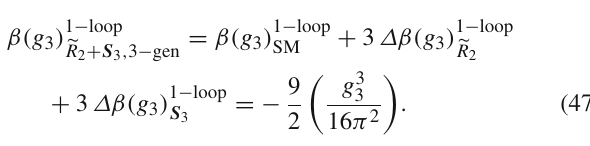
Fig. 2 Running of gauge coupling g 3 with the energy scale μ for dif- ferent leptoquark models at one-loop and two-loop order. The green curve represents SM; the red and yellow ones signify the extension of SM with one and three generations of (cid:2) R 2 , respectively; the addition of one and three generations of S 3 to SM is indicated by the blue and